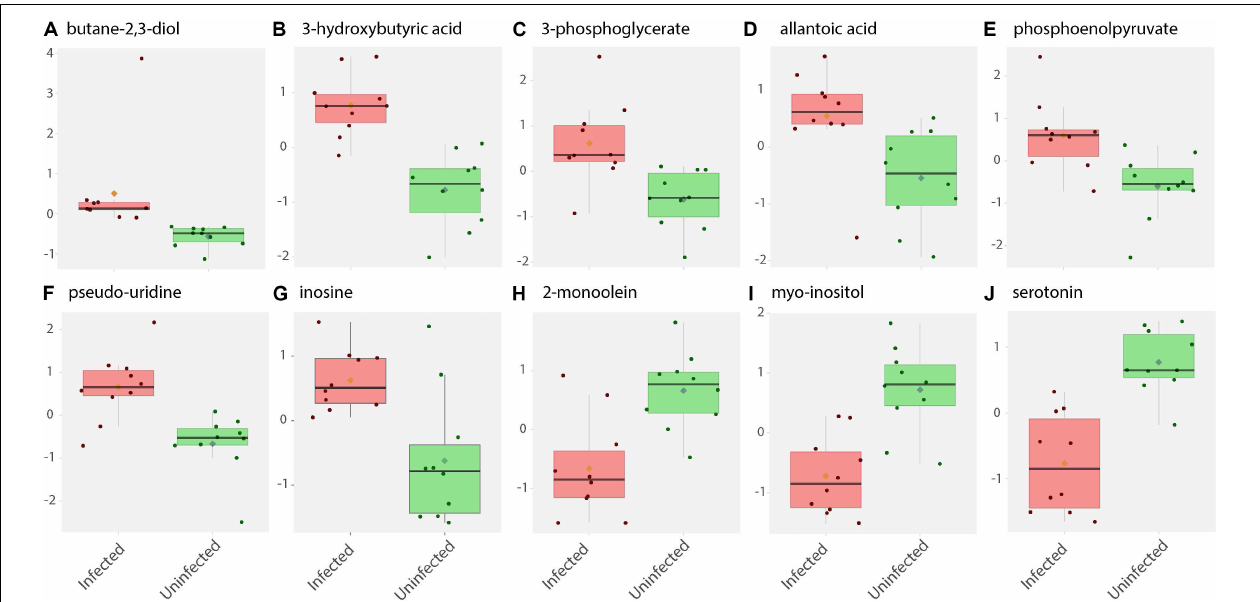
FIGURE 2 | Box and whisker plots of biochemical abundance of metabolites in ZIKV-infected Ae. albopictus whole bodies. Untargeted metabolic analysis was utilized to screen for primary metabolites in Ae. albopictus females infected with ZIKV (ZIKV- positive legs). The metabolites were profiled using Gas Chromatography time of flight (GC TOF) protocol. The data was analyzed using the MetaboAnalyst (v4.0) package. Each plot (A–J) represents an individual compound as labeled. Compounds were selected based on fold change analysis with threshold log fold change values ≥ 2 and an FDR adjusted p -value of < 0.05. The individuals exposed to ZIKV infected blood meal (8.3 log 10 PFU/ml ZIKV HND strain) are represented by a pink box and whisker plot while individuals exposed to non-infectious blood meal are represented by a green box and whisker